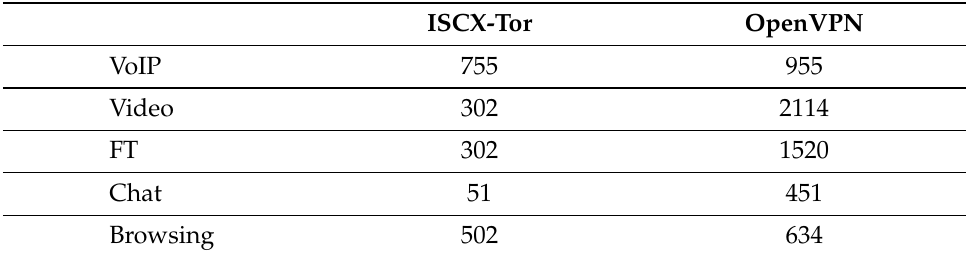
Table 2. The number of sessions in ISCX-Tor and